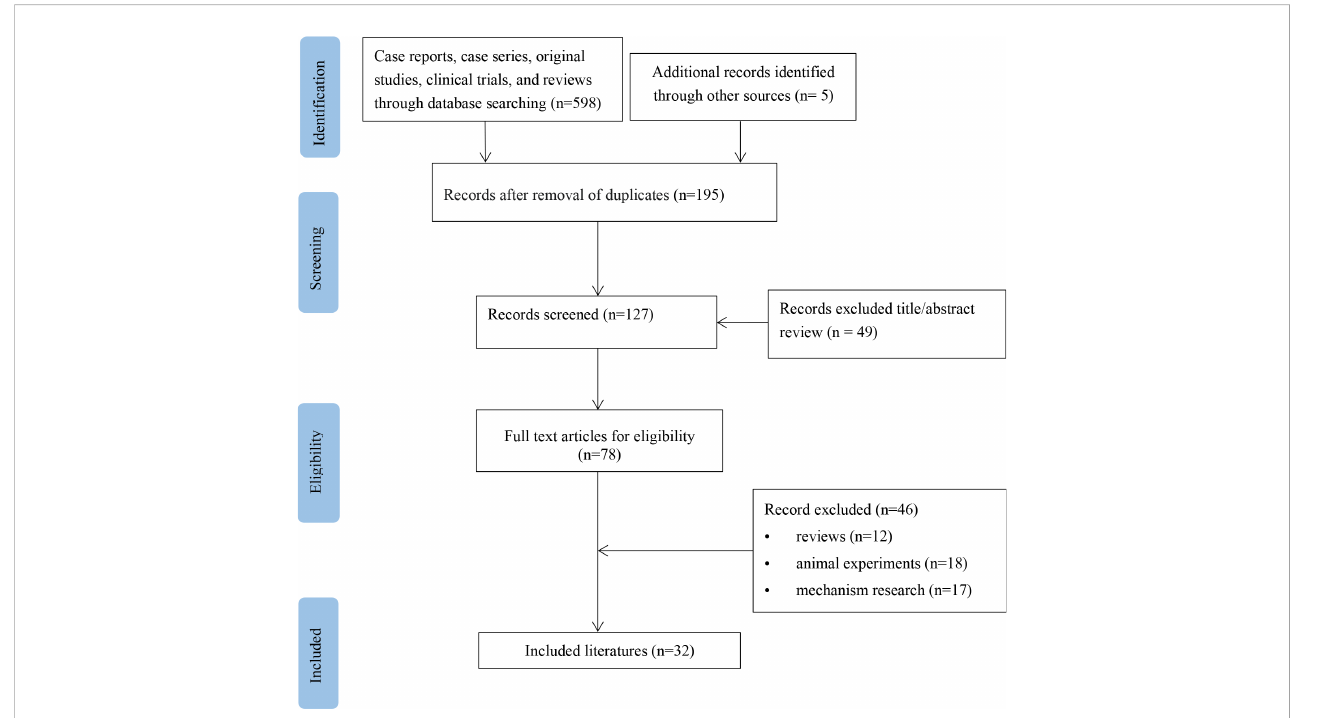
FIGURE 1 Flow chart of study selection process for reported cases of trimethoprim-sulfamethoxazole-induced